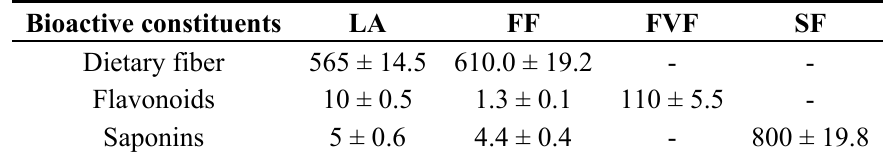
Table 1. Major bioactive constituents (mg/g dry matter) in the asparagus